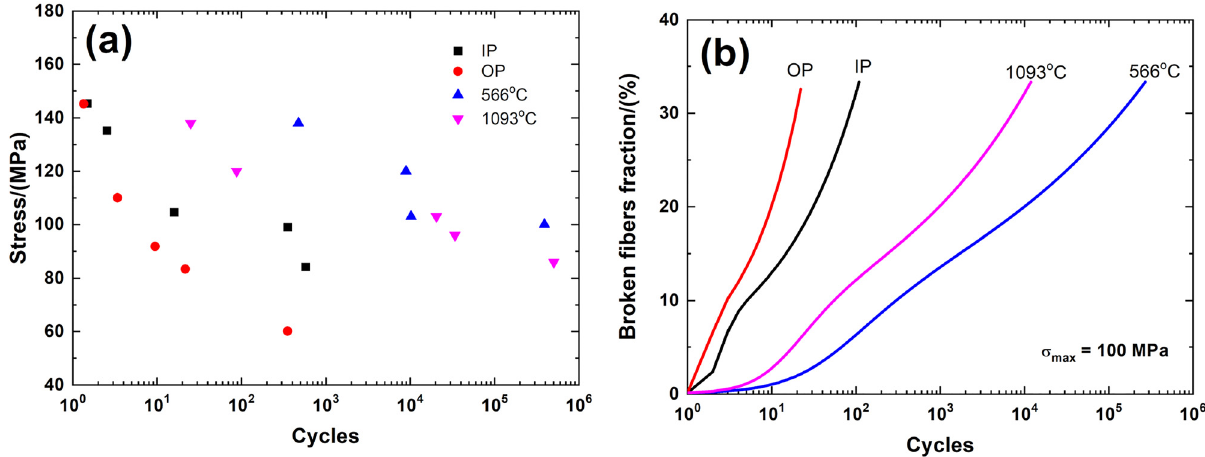
Figure 15: ( a ) Fatigue life S – N curves, and ( b ) the FBFF versus applied cycle number curves under the fatigue peak stress σ max = 100 MPa of cross - ply SiC/MAS composite under IP - and OP - TMF and IF